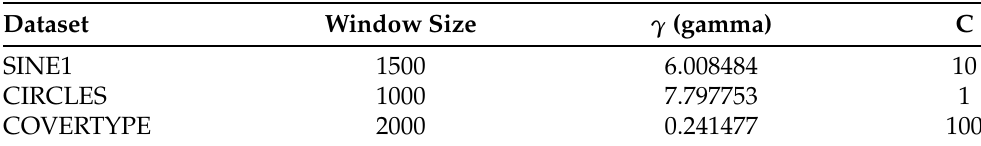
Table 1. C-SVM and AIDSVM parameters used for each data set.